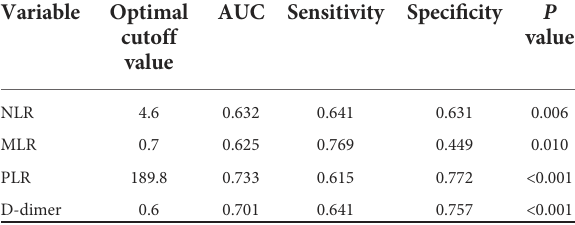
TABLE 1 The ROC and AUC to determine the optimal cutoff value for each index in continuous variable. Variable